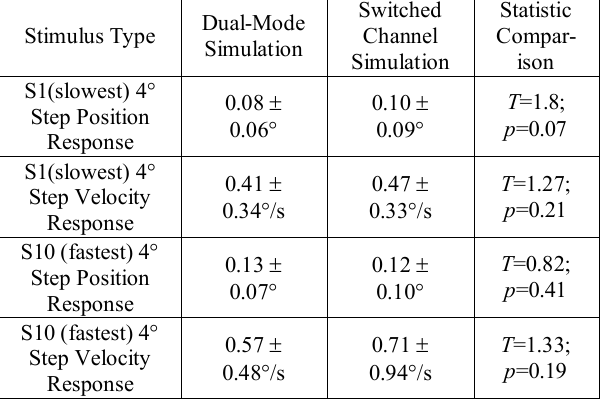
Table 2: Average error with one standard deviation for the entire response for the dual-mode and switched-channel simulations compared to the 4  experimental responses with a paired t-test statistical comparision.